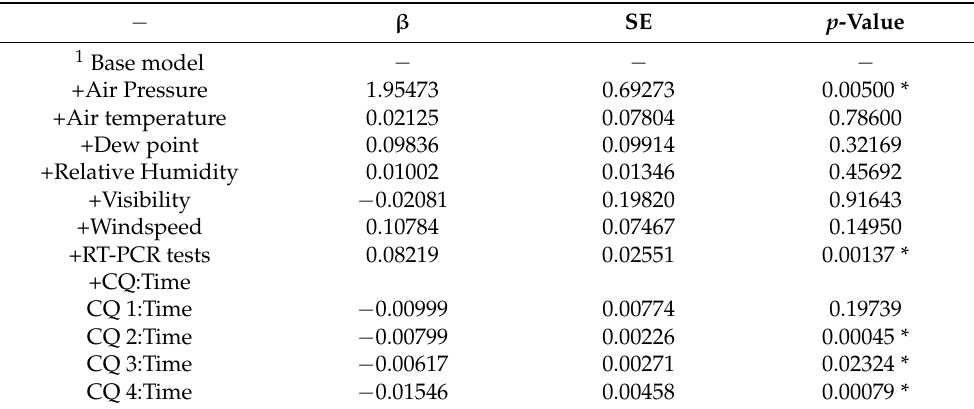
Table 2. Association of same-day exposure variables and R t .